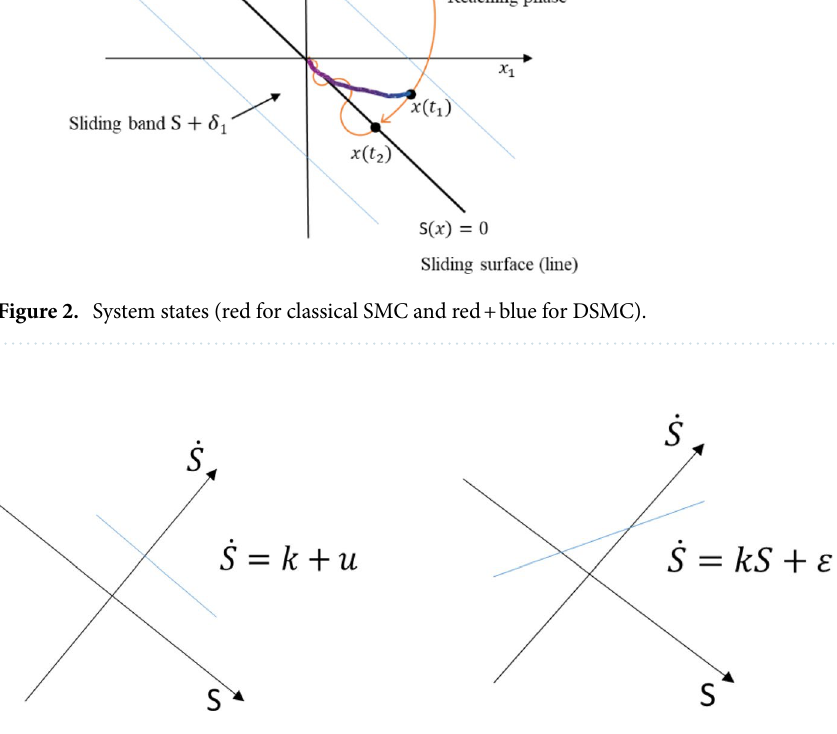
Figure 3. Sliding function coordinate system of ( S ,